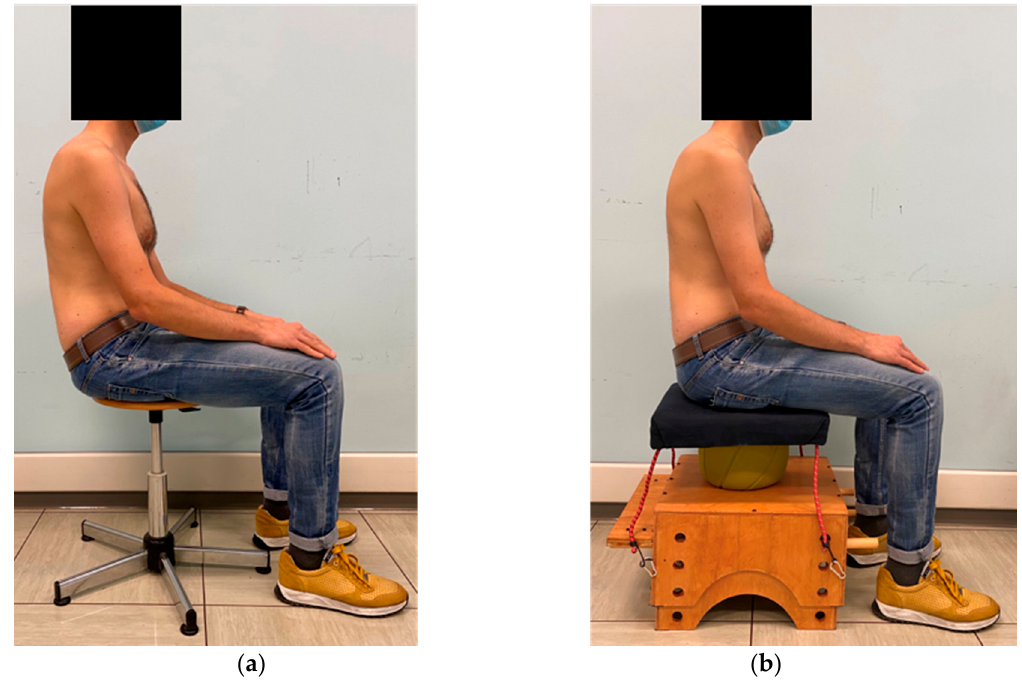
Figure 2. Sitting conditions for evaluation: ( a ) conventional sitting posture on a standard stool; ( b ) dynamic sitting posture on the “EnergyBack” dynamic stool (prototype).